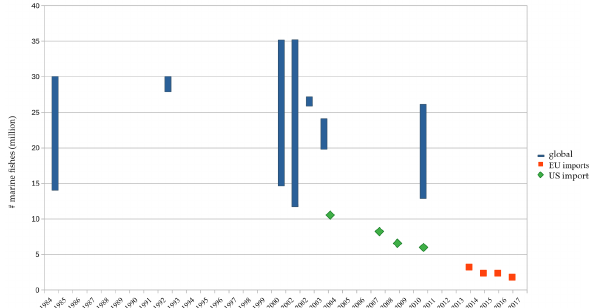
between 1984 and 2010 and imports to the United States for 2004 / 2005 (green) [5,8] and the EU (red)